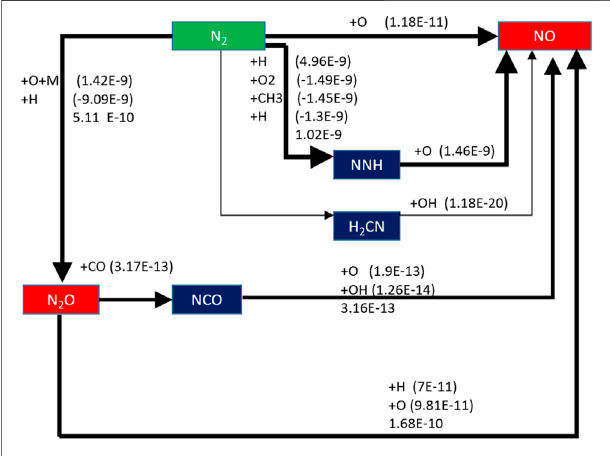
FIGURE 16 | Generation path of NO when equivalent ratio is